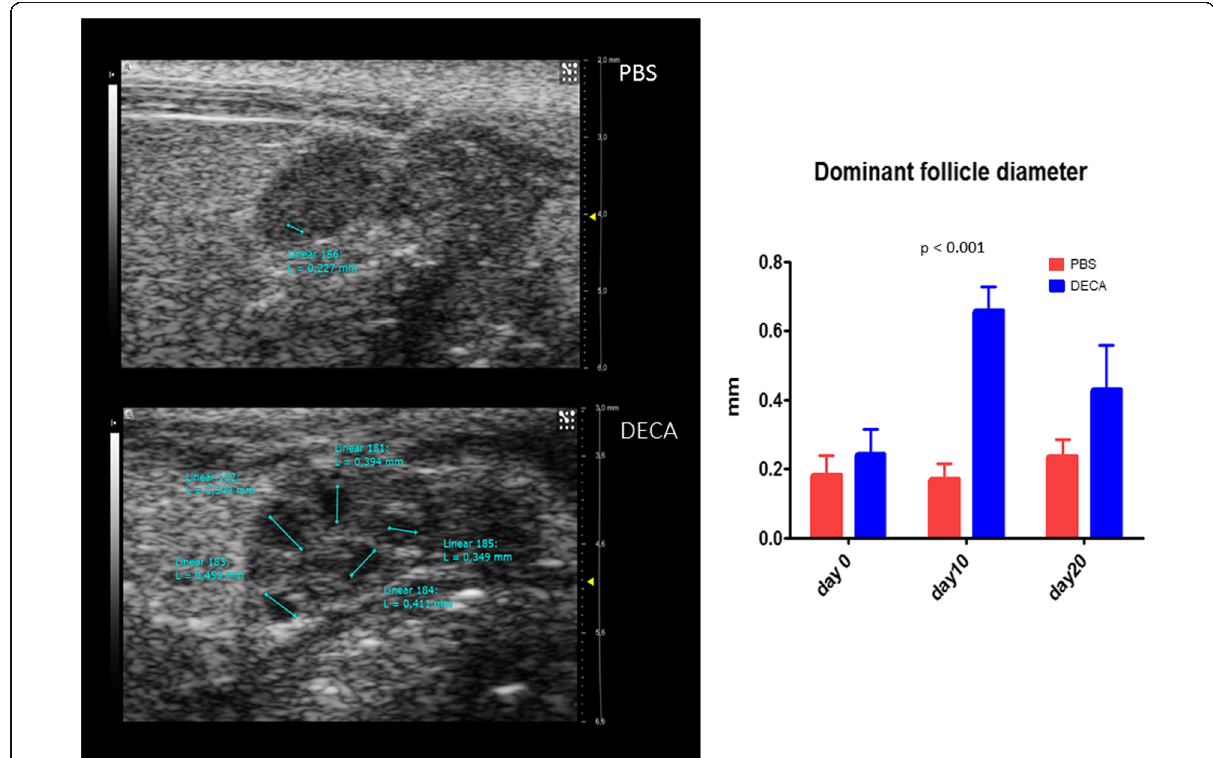
Fig. 3 US images ( arrows ) show the increase in the diameter of the dominant follicle in a decapeptyl-treated mouse ( DECA ) compared with a control mouse, which received only phosphate-buffered saline ( PBS ). The graph shows the comparison between the dominant follicle diameter of PBS-treated mice and that of decapeptyl-treated